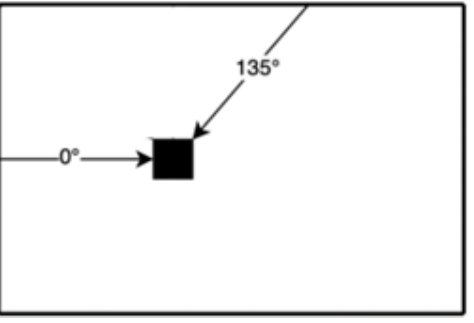
Figure 3. Cost aggregation path.